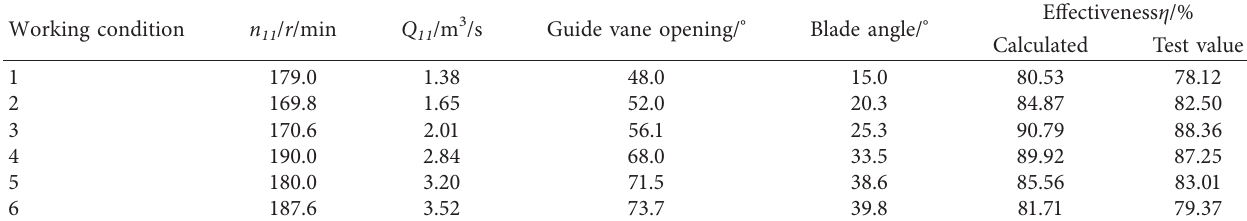
Table 5: Comparison of numerical simulation calculation and test results under different working conditions.